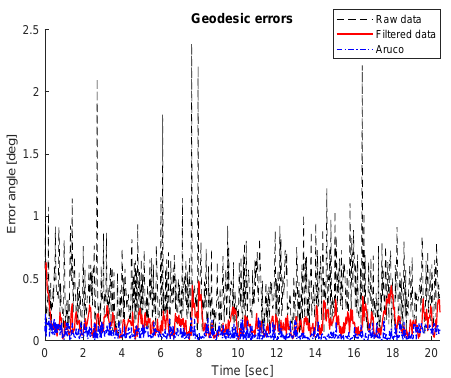
Figure 5: Angular distance with raw VPD data (dashed black curve), filtered VPD data (red curve) the found truth from the ArUco sys- tem (blue